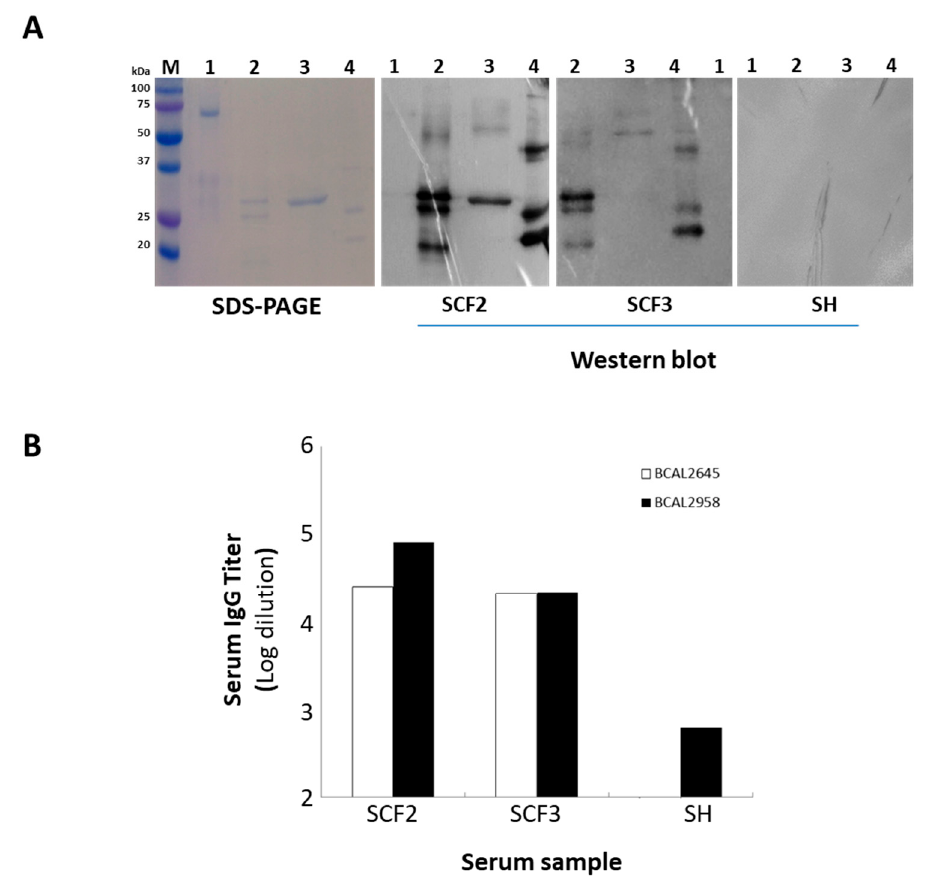
Figure 5. A —SDS-PAGE and Western blot of the purified recombinant proteins BCAL2022, BCAL2645 and BCAL2958 from B. cenocepacia J2315 probed with the human serum samples SCF2 and SCF3 from CF patients with positive cultures of Bcc bacteria or a pool of human serum samples from healthy donors (SH). Lanes: M—Precision Plus ProteinTM DualXtra Standard (BIORAD); 1—BSA; 2—purified recombinant protein BCAL2958; 3—purified recombinant protein BCAL2022; 4—purified recombinant protein BCAL2645; B —levels of IgG antibody against BCAL2645 and BCAL2958 proteins present in serum samples from CF patients with clinical history of Bcc infection (SCF2 and 3) and in healthy individuals (SH). Serum antibody concentrations were defined as endpoint titers and were calculated as the reciprocal of the highest serum dilution producing an OD 450 above the cut-o ff value. The cut-o ff value was determined as the mean OD 450 negative control plus 3 standard deviations. Titers of ≥ 700 and ≥ 100 were considered as positive for BCAL2958 and BCAL2645, respectively. The IgG titer data for BCAL2958 were previously obtained in [26].